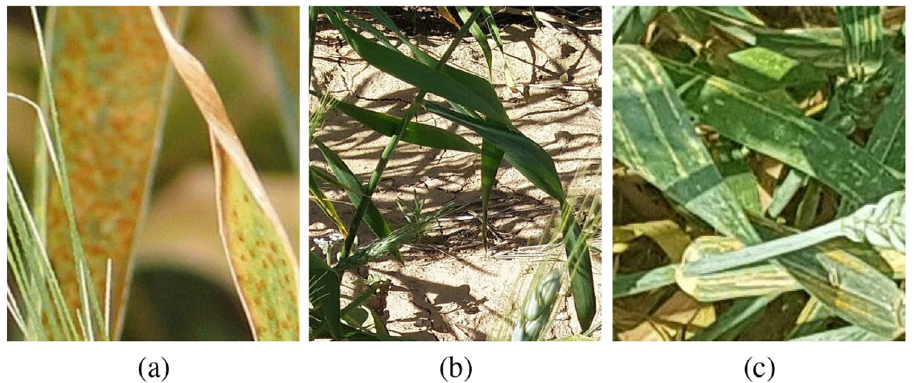
Figure 1. Sample images from Wheat Rust Classification Dataset: ( a ) brown rust, ( b ) healthy wheat, and ( c ) yellow